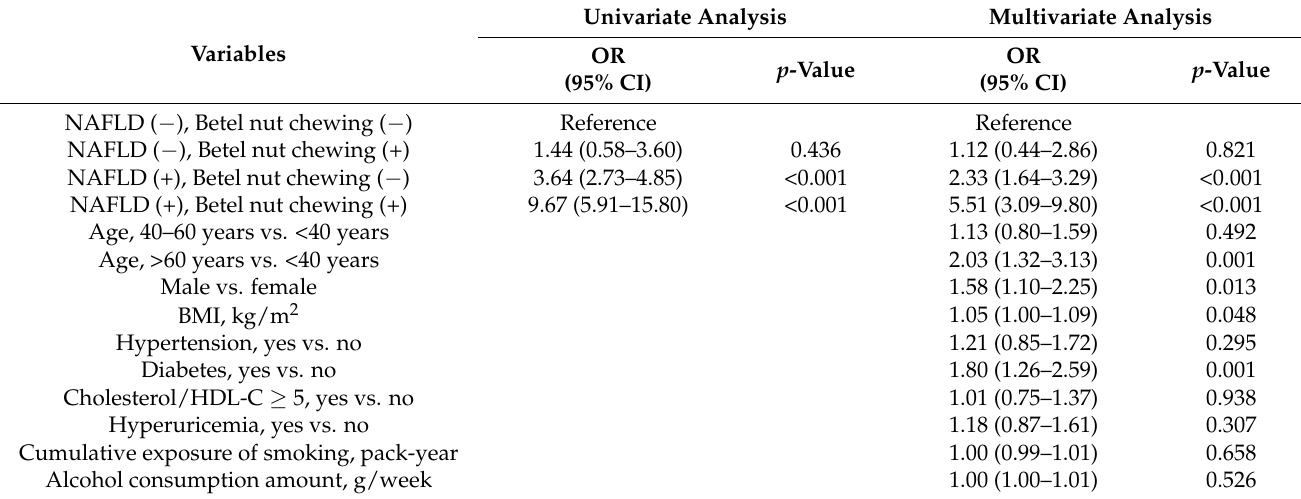
Table 2. Logistic regression model for risk of significant liver fibrosis (defined as APRI ≥ 0.5). Univariate Analysis Multivariate Variables